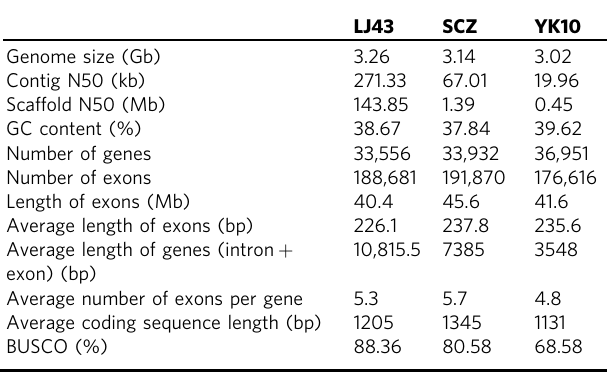
Table 1 Genome assembly and annotated genes of the three tea